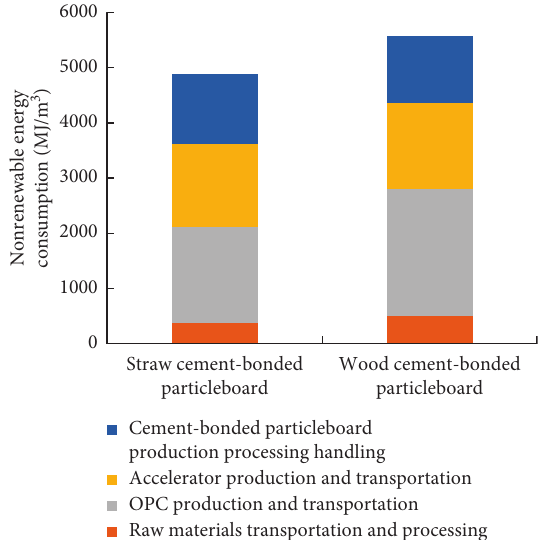
Figure 6: Contribution of cement-bonded particleboard produc- tion process to nonrenewable energy